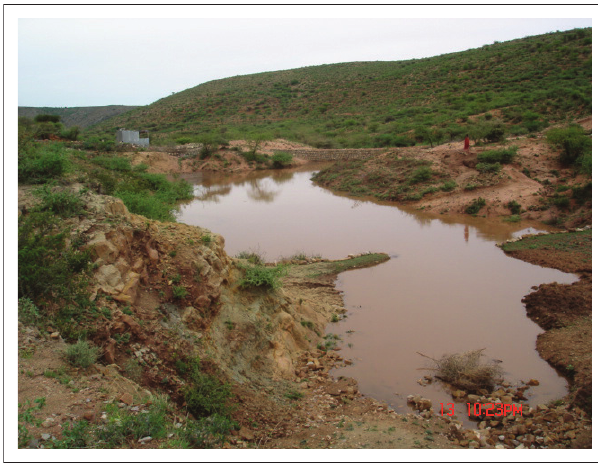
FIGURE 5: Part of the steep slopes and rugged